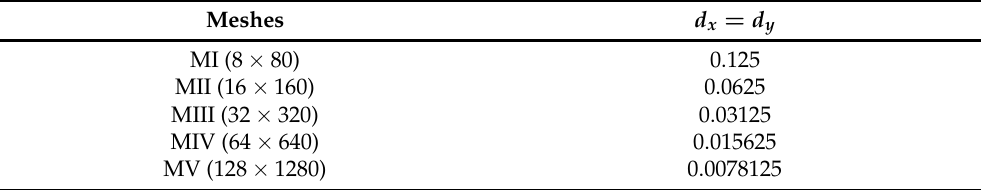
Table 3. Uniform meshes.